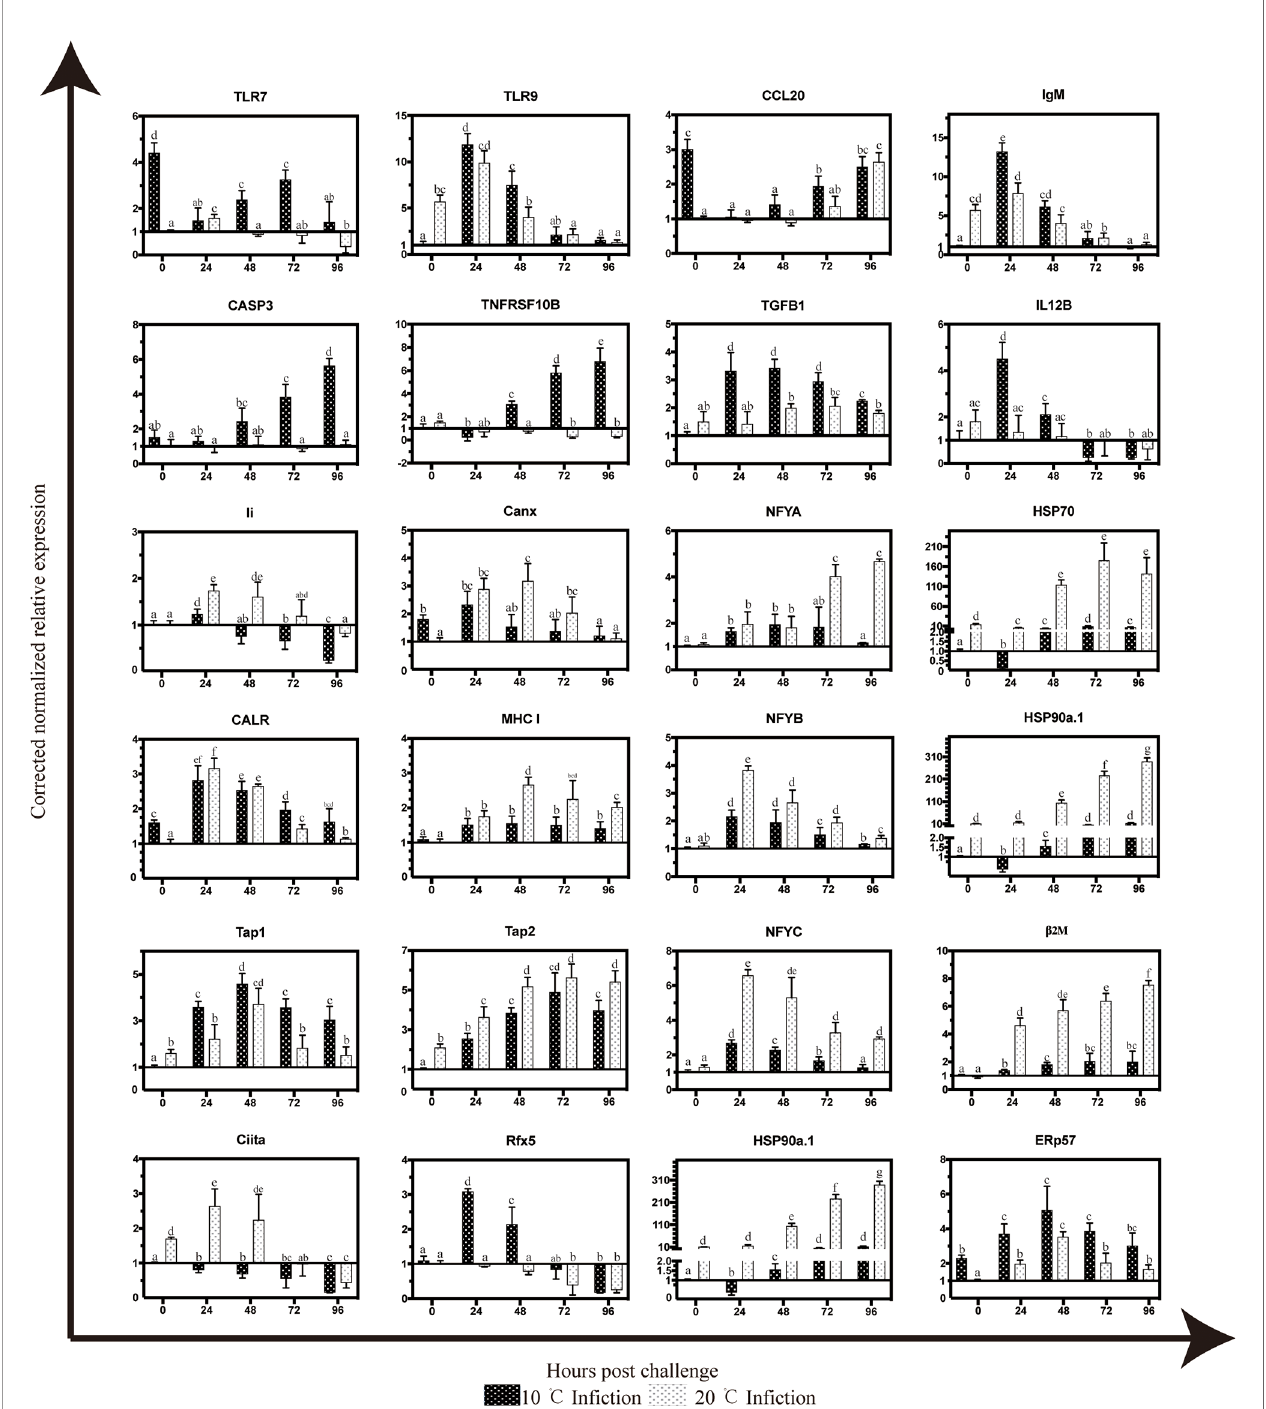
FIGURE 6 | Temporal expression patterns of selected gene targets in mIgM + B lymphocytes of infected fl ounder as assessed by qPCR. The results were presented as the means ± SEM of three individuals, different letters above the error bars indicate signi fi cant differences ( p <